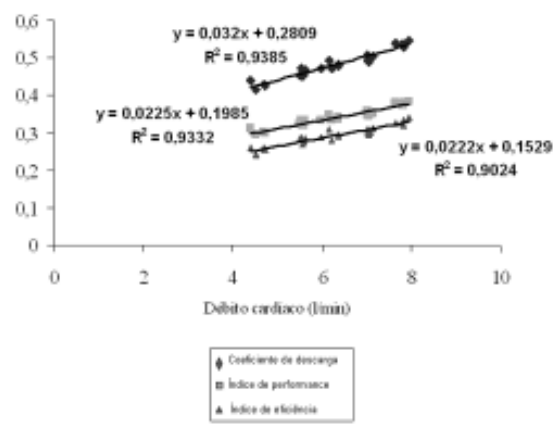
Fig. 5 – Análise do coeficiente de descarga, índice de